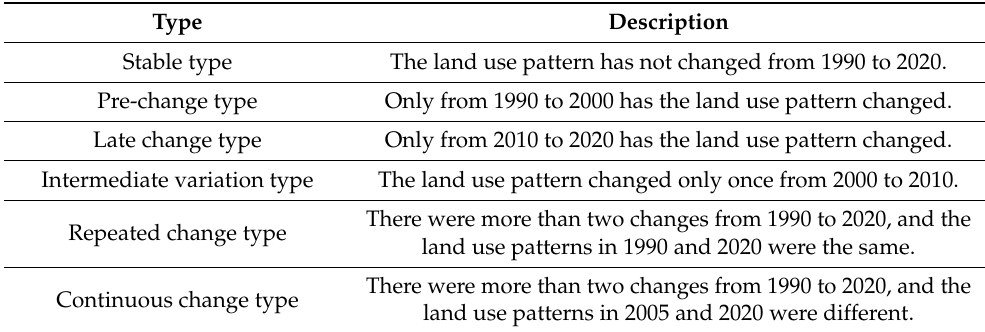
Table 3. Map change patterns of the Yellow River Basin (Henan section) from 1990 to